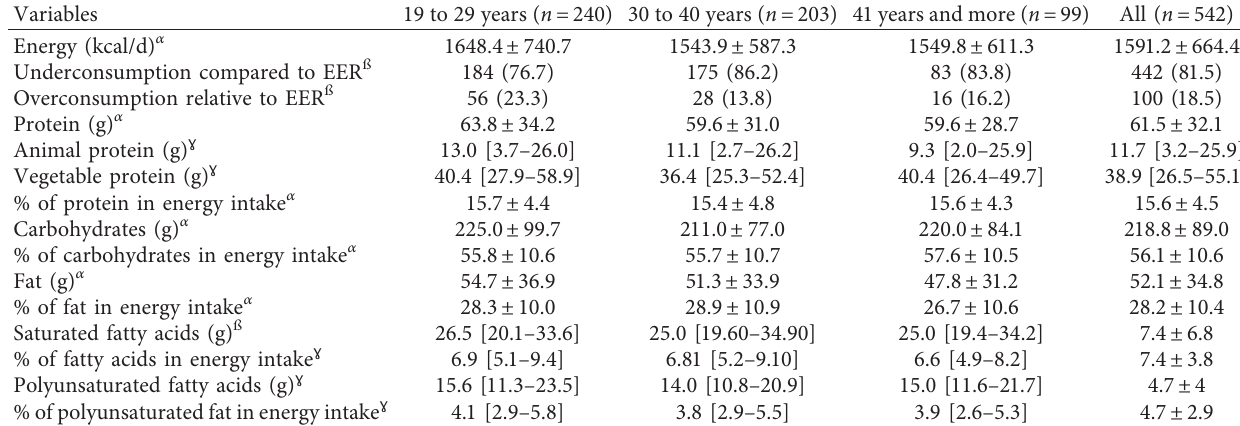
Table 3: Average daily energy and macronutrients intakes by age